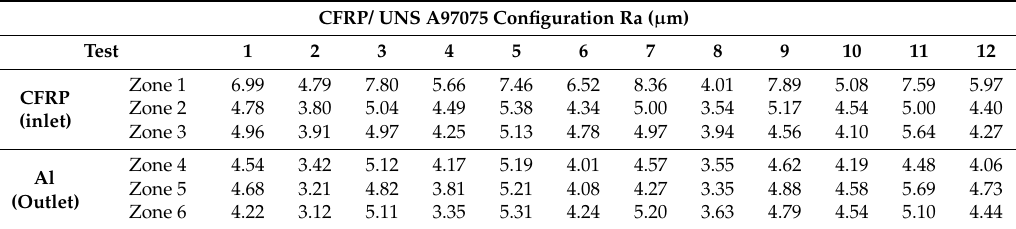
Table A4. Average roughness CFRP /UNS A97075